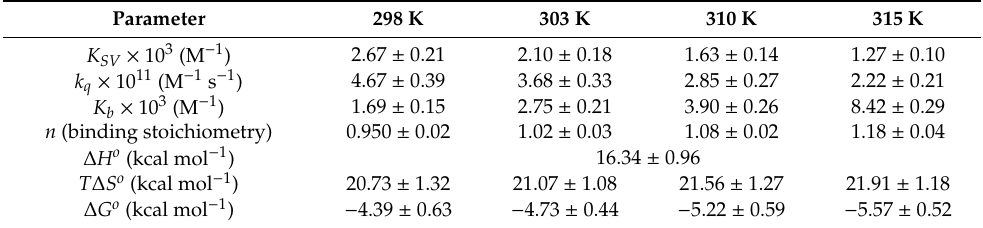
Table 1. Binding and thermodynamic parameters of 2,4-TZD / HSA binding as determined by fluorescence quenching. Values are means of triplicates ±